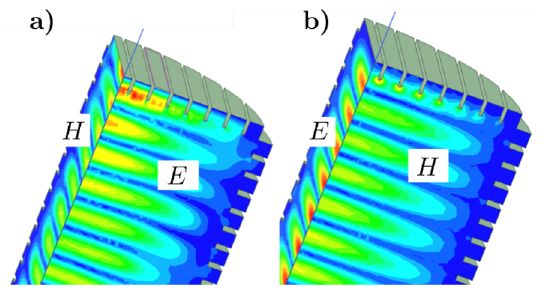
Figure 6 . Cavity with corrugated end- and side-walls, R = 3 (cid:21) . Shown are density plots of the E and H (cid:12)elds as labeled. a) Fields for mode with electric (cid:12)eld polarized perpendicular to end-wall vanes. b) Fields for mode with electric (cid:12)eld polarized parallel to end-wall